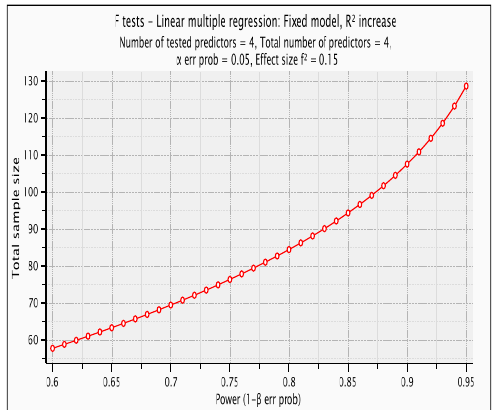
Figure 3. X-Y Plot for Medium Effect Power